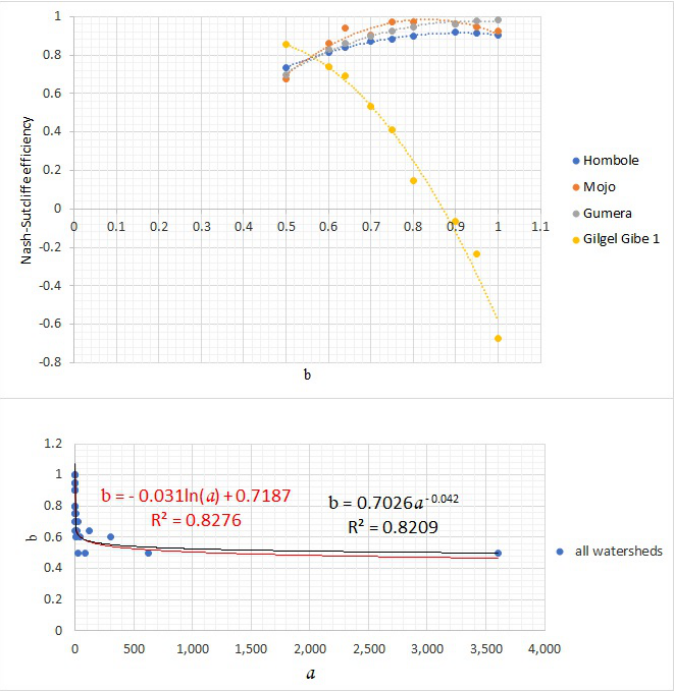
Figure 24. The relationship between exponent b versus the Nash–Sutcliffe efficiency and the coeffi- cient a versus the exponent b when the topographic factor is calculated using the equation that was proposed by McCool et al. (1987) as cited in